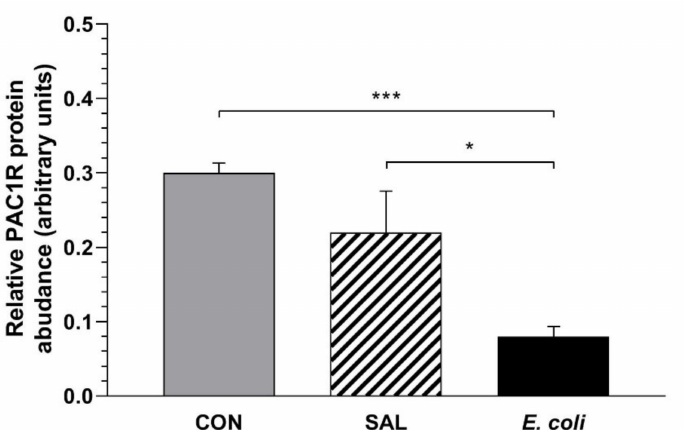
Figure 2. Relative pituitary adenylate cyclase-activating peptide receptor (PAC1R) protein abun- dances in the myometrial layer of gilts from the control (CON), saline (SAL) and E. coli ( E. coli ) groups, estimated by Western blot analysis. The relative PAC1R protein abundances are expressed as the mean ± SEM of ratios in relation to glyceraldehyde-3-phosphate dehydrogenase (GAPDH). The blot with representative bands for each group is presented in Supplementary Figure S2. * p < 0.05, *** p < 0.001 compared between